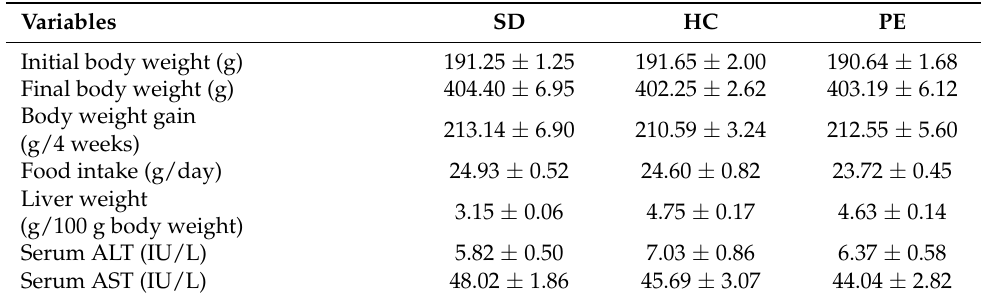
Table 4. Effect of PE on physiological variables.